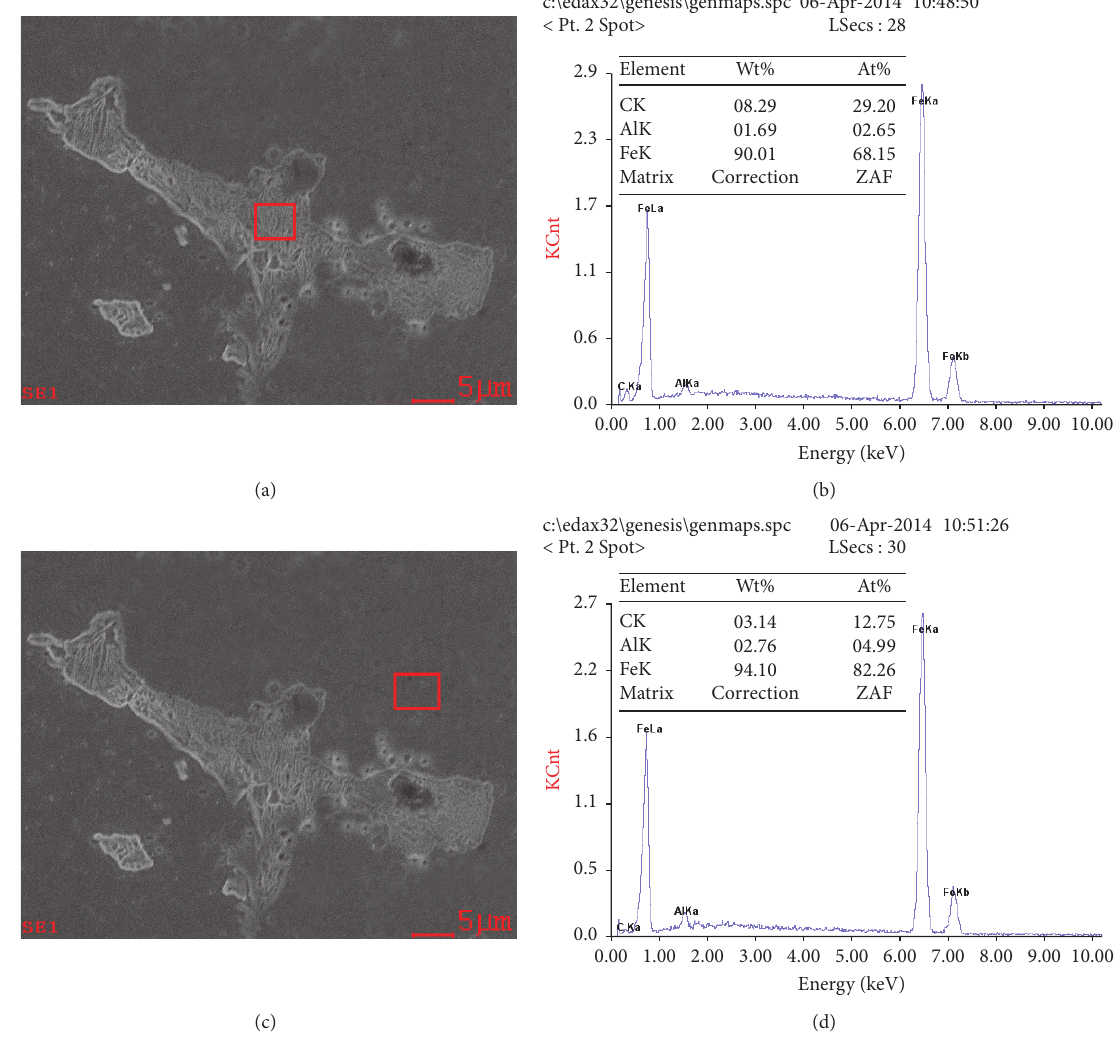
Figure 6: EDS elements analysis of the cast 1045 steel ((b) is correspondence of red region in (a); (d) is correspondence of red region in